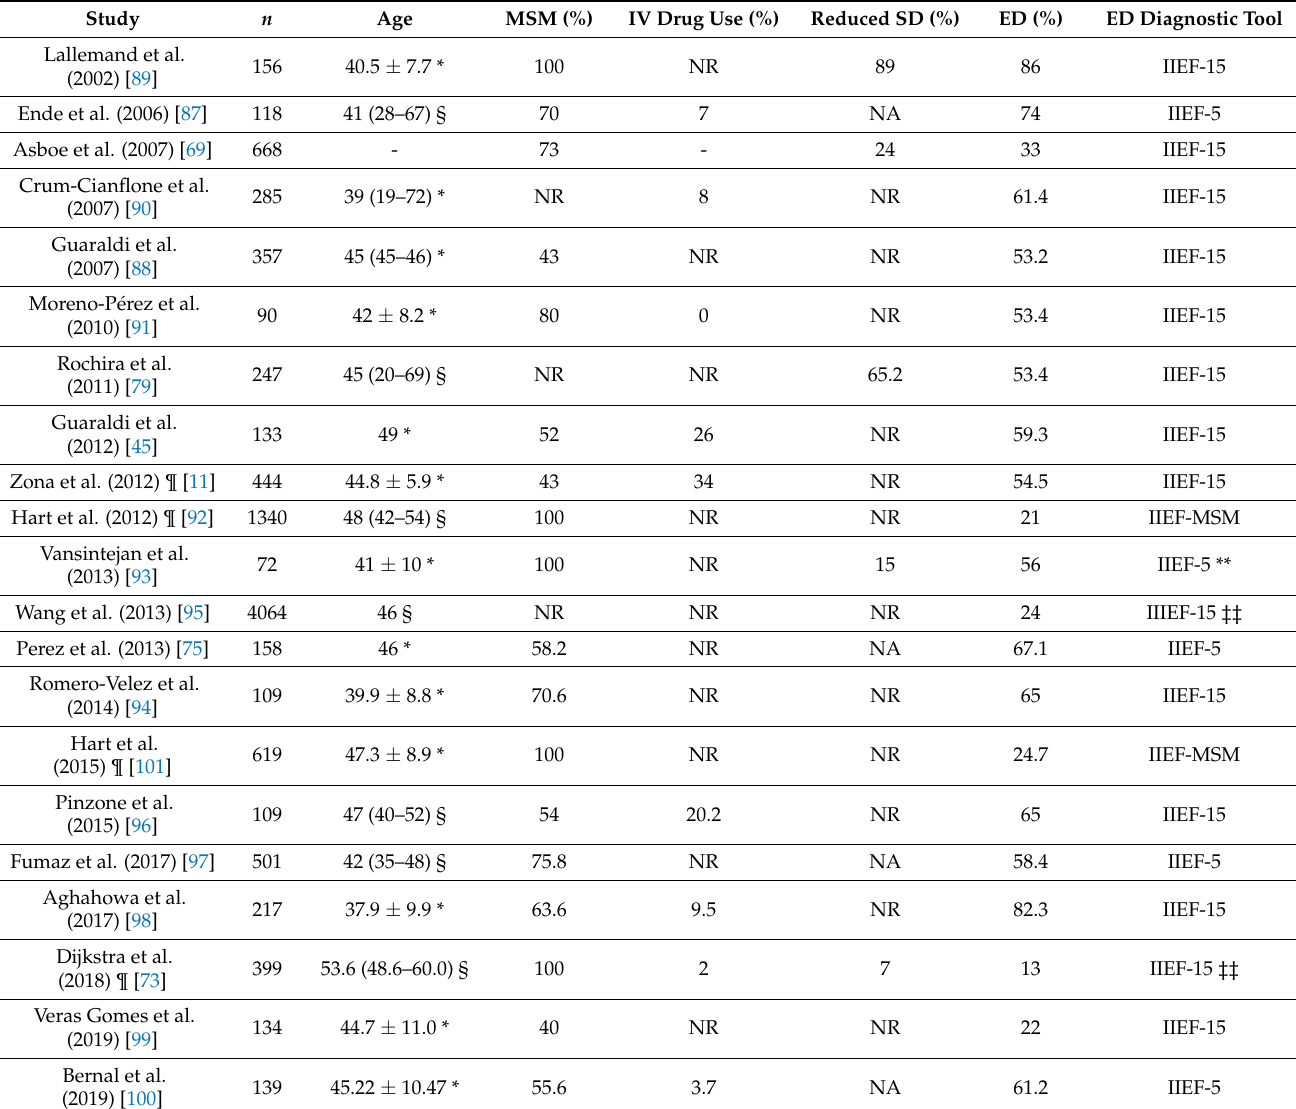
Table 2. Studies that investigated erectile dysfunction (ED) and reduced libido prevalence in HIV